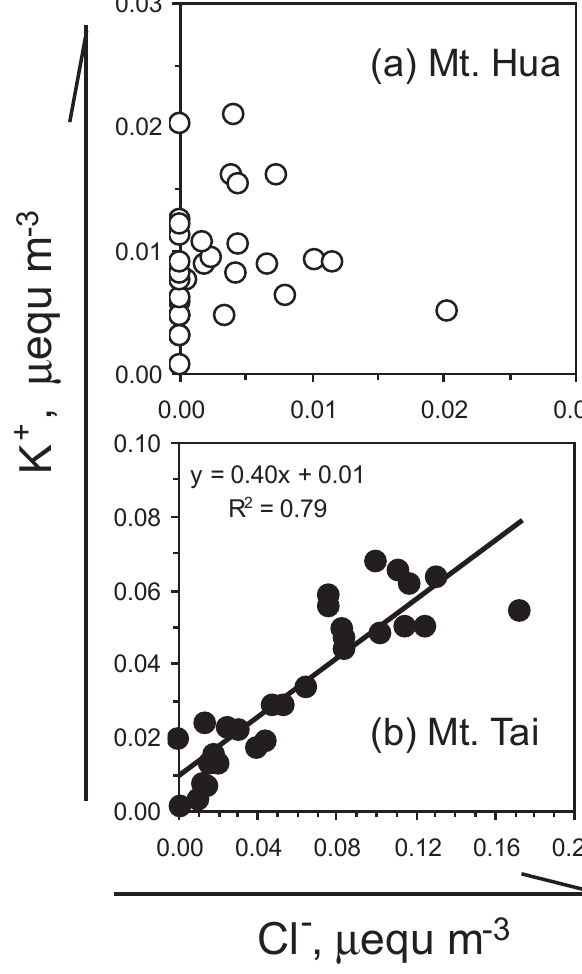
Fig. 5. Correlation of K + and Cl − in PM 10 at Mt. Hua and Mt. Tai during the non-dust storm